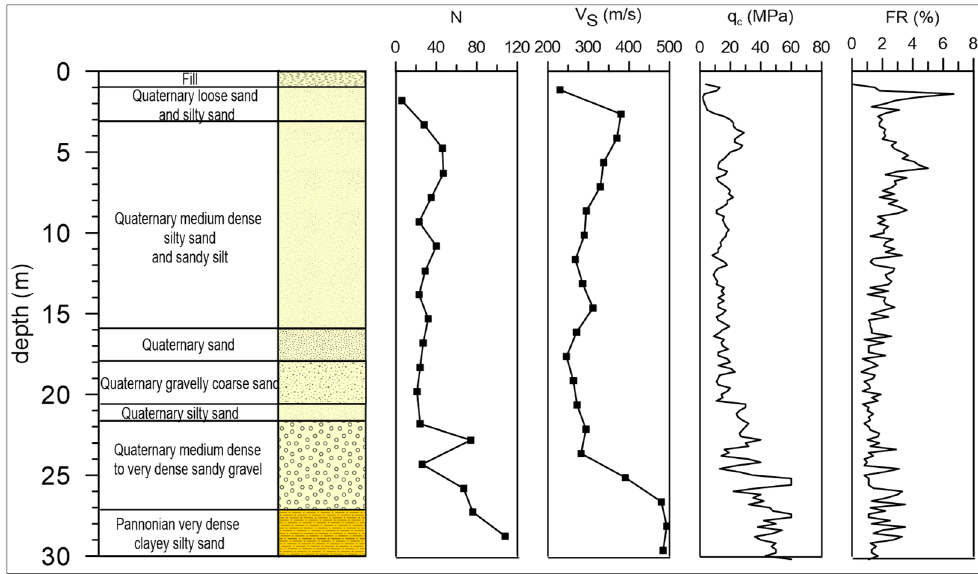
Figure 3. Example for soil properties at the site of the Paks NPP (N is the SPT count, vs. is the shear wave velocity, q is the cone resistance, and FR is the friction ratio). The water table is at − 8 m. Altogether, 17 liquefaction hazard evaluation methods have been applied for the site including the full probabilistic method of Kramer and Mayfield [16] shown in Figure 4